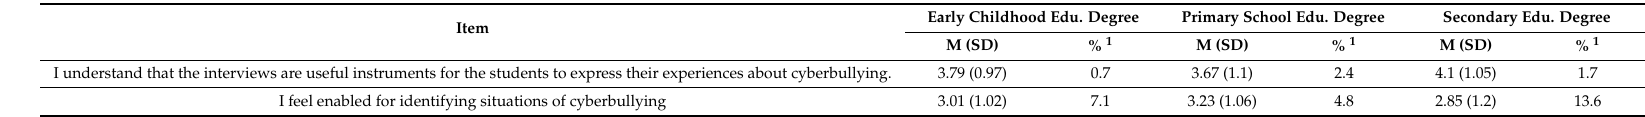
Table 2. Descriptive data according to degree